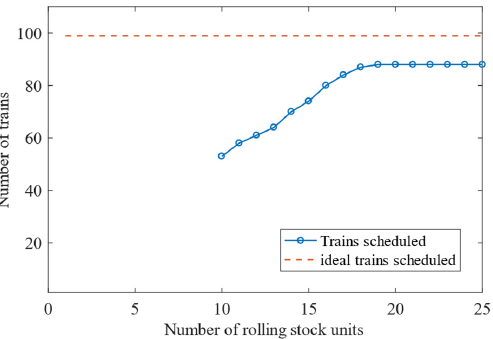
Figure 12. The variation of number of trains scheduled under different values of |𝐿| .